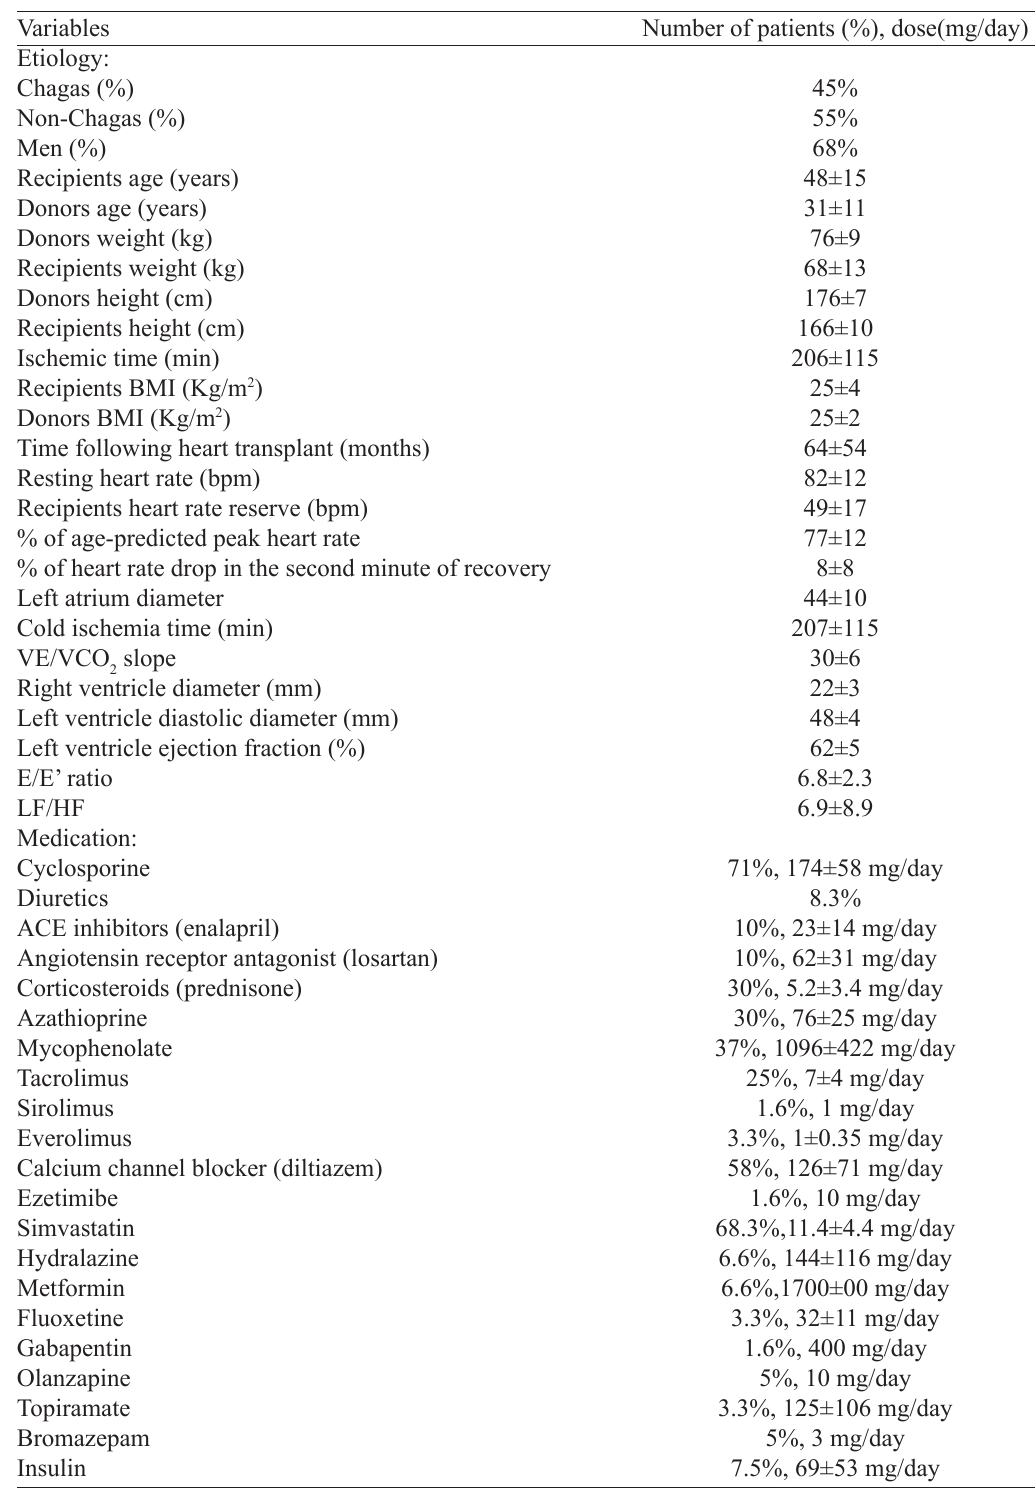
Table 1. Characterization of study